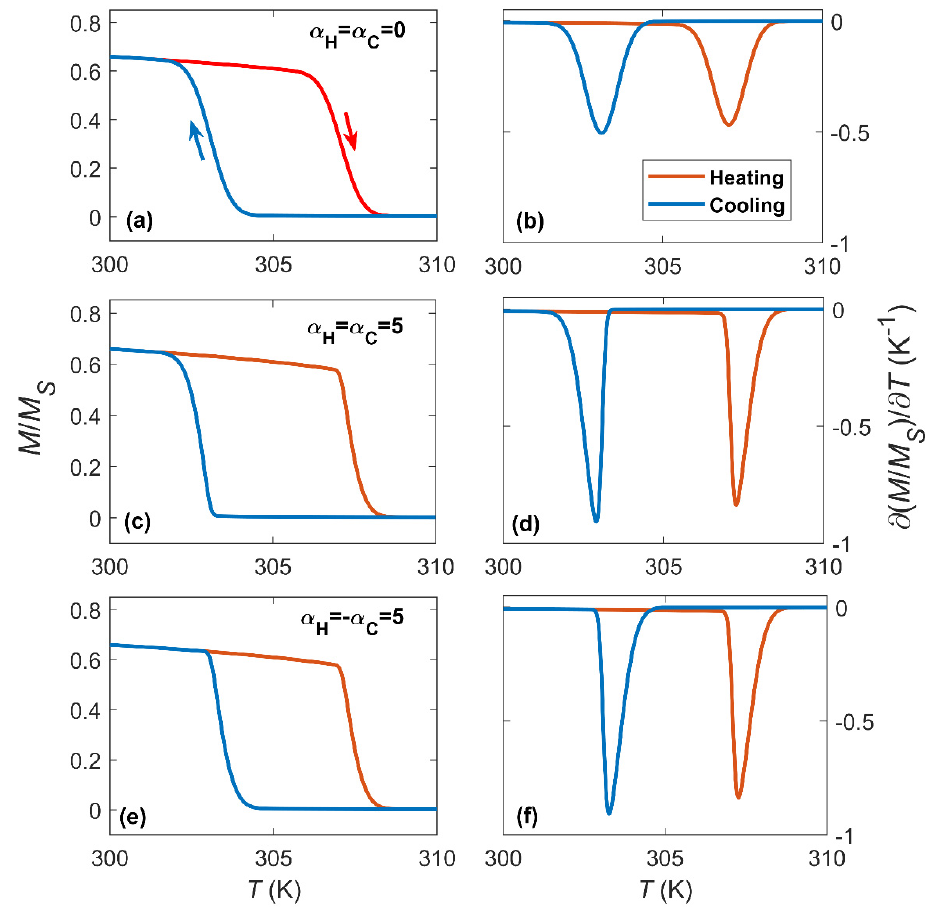
Figure 6. Temperature dependence of the magnetization and its first derivative with respect to the temperature with ξ H = T t , ST + 2 K, ξ C = T t , ST − 2 K, σ H = σ C = 0.5 K and ( a , b ) α H = α C = 0, ( c , d ) α H = α C = 5, ( e , f ) α H = − α C = 5 .